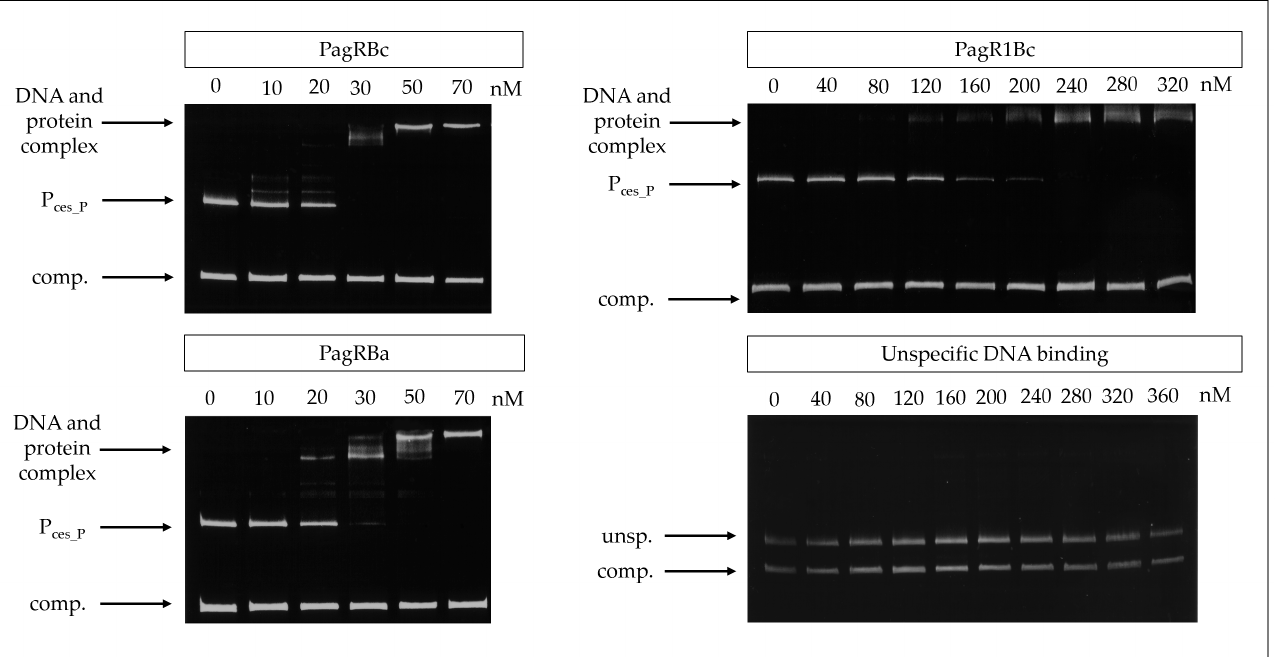
Figure 3. Gel mobility shift assay to determine the in vitro affinity of PagR homologues (PagRBc, PagR1Bc and PagRBa) to the ces gene promoter region of emetic B. cereus . The PagR homologues’ potential to bind to the ces promoter (P ces_P ) was conducted in vitro using different amounts (0 nM up to 360 nM) of DNA comprising the promoter region of the ces operon or equimolar amounts of a competitive negative control DNA fragment (comp.), respectively. PagR concentrations are indicated in nM concerning the monomer on the top of each panel. Specificity of binding was further tested by using randomly amplified DNA from B. cereus (unsp.) with the competitive negative control DNA fragment (comp.) and increasing concentrations of purified PagR1Bc (lower right panel). A representative result from three independent experiments is shown.